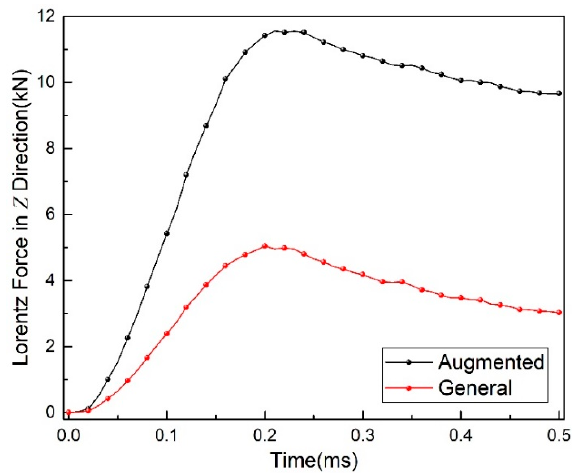
Figure 15. Thrust of augmented quadrupole railgun and non-augmented quadrupole.